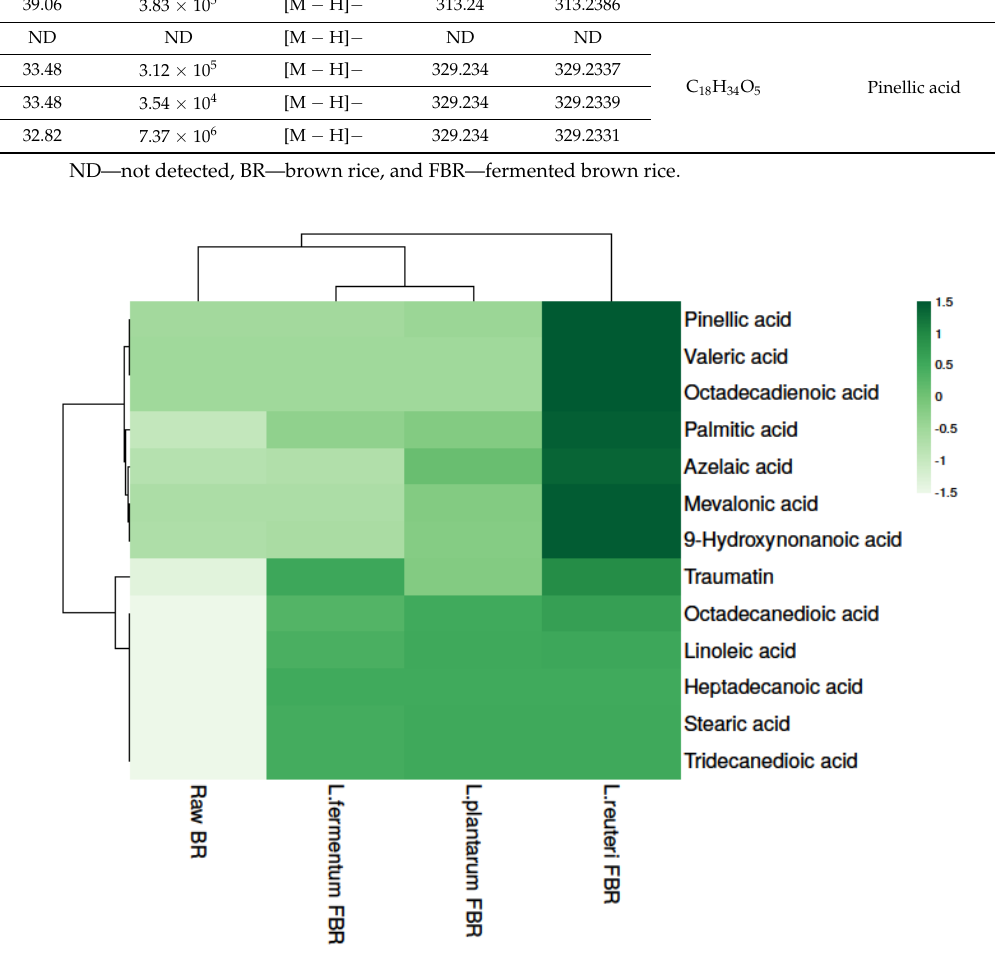
Figure 3. Heat map showing levels of fatty acids in raw and different LABs fermented BR